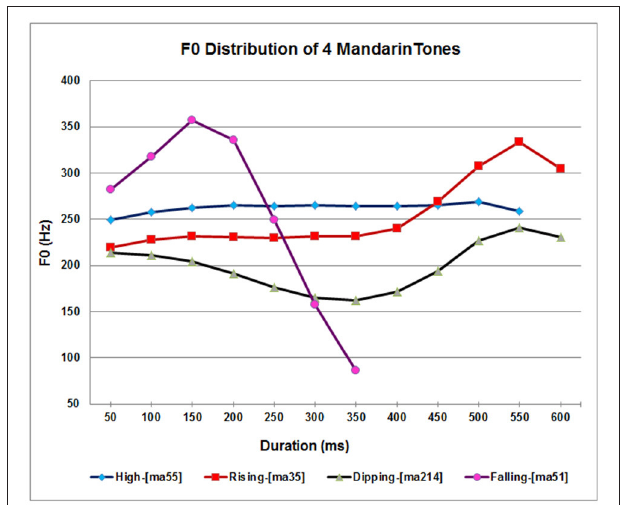
FIGURE 1 | Fundamental frequency (F0) plots over time for the four Mandarin tones on the syllable /ma/ meaning “mother” [ma55]; “hemp”[ma35]; “horse”[ma214]; and “scold”[ma51] produced by four female native speakers of Beijing Mandarin dialect.